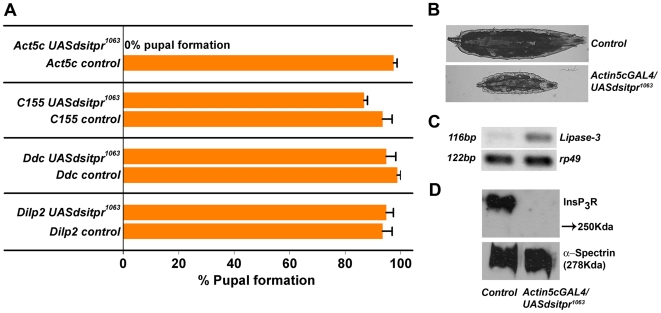
Ubiquitous but not tissue specific knockdown of itpr recapitulates itprsv35/ug3 phenotypes.(A) Act5c dsitpr larvae (Act5cGAL4/UASdsitpr1063) did not undergo pupation and died as 3rd instars. The number of pupae formed in Dilp2 dsitpr (Dilp2GAL4/UASdsitpr1063; UASdicer/+), Ddc dsitpr (DdcGAL4/UASdsitpr1063; UASdicer/+) and C155 dsitpr (ElavC155GAL4; UASdsitpr1063/+;UASdicer/+) was similar to controls (not significant; p>0.05; Student's t-test). GFP positive larvae were used as controls in each RNAi experiment. Three batches of 25 2nd instar larvae were screened for each of the indicated genotypes. Results are expressed as mean±SEM. (B) Significant reduction in larval size was observed in Actin5cGAL4/UASdsitpr1063 3rd instars (∼120 hrs AEL) compared to controls (Actin5cGAL4 or UASdsitpr1063/CyoG). (C) RT-PCR gel with up-regulation of dLipase-3 transcript levels in RNA isolated from Actin5cGAL4/UASdsitpr1063 larvae (∼ 85 hrs AEL) compared to RNA from controls. (D) A western blot with reduced InsP3R (280Kda) protein levels in lysates from Actin5cGAL4/UASdsitpr1063 3rd instar (∼120 hrs AEL) larvae as compared to lysates from controls. Equal levels of the loading control α-spectrin (278Kda) confirm that similar quantities of protein lysates were loaded in each lane.